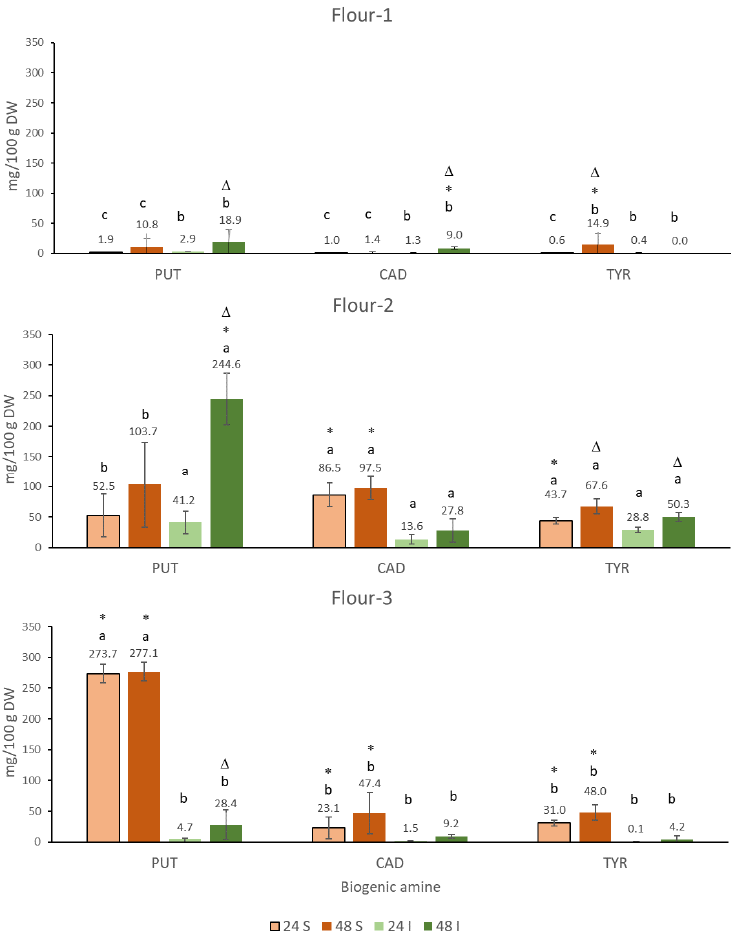
Figure 1. Putrescine (PUT), cadaverine (CAD), and tyramine (TYR) in chickpea sourdoughs from Flour-1, Flour-2, and Flour-3 prepared by spontaneous fermentation (S) and inoculated fermentation with commercially available starter culture (I) after 24 h and 48 h of fermentation at 30 °C. The differences in the content of particular compound that are attributed to flour origin at fixed duration and type of fermentation are marked with different letters (a, b, c); different duration of fermentation at fixed flour origin and type of fermentation is marked with Δ ; type of fermentation at fixed flour origin and duration of fermentation is marked with *. The differences were significant at the p < 0.05 level.